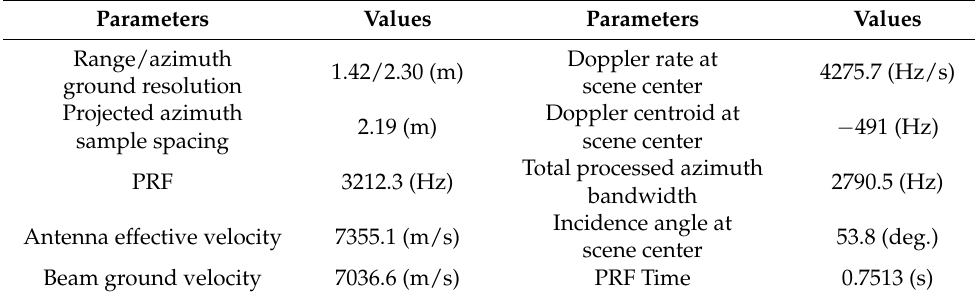
Figure 1. Doppler spectra of a true ship and azimuth ambiguity (or ghost). ( a ) Power spectra presented in decibel units. ( b ) Power spectra presented as normalized spectral power overlaid with three sub-apertures that were used for multi-look processing in this study. While the Doppler spectrum of the ship is spread over the entire spectral band, that of the azimuth ambiguity is characterized by a narrow bandwidth centred close to ± PRF/2. Table 1. System parameters of the TSX data used in this